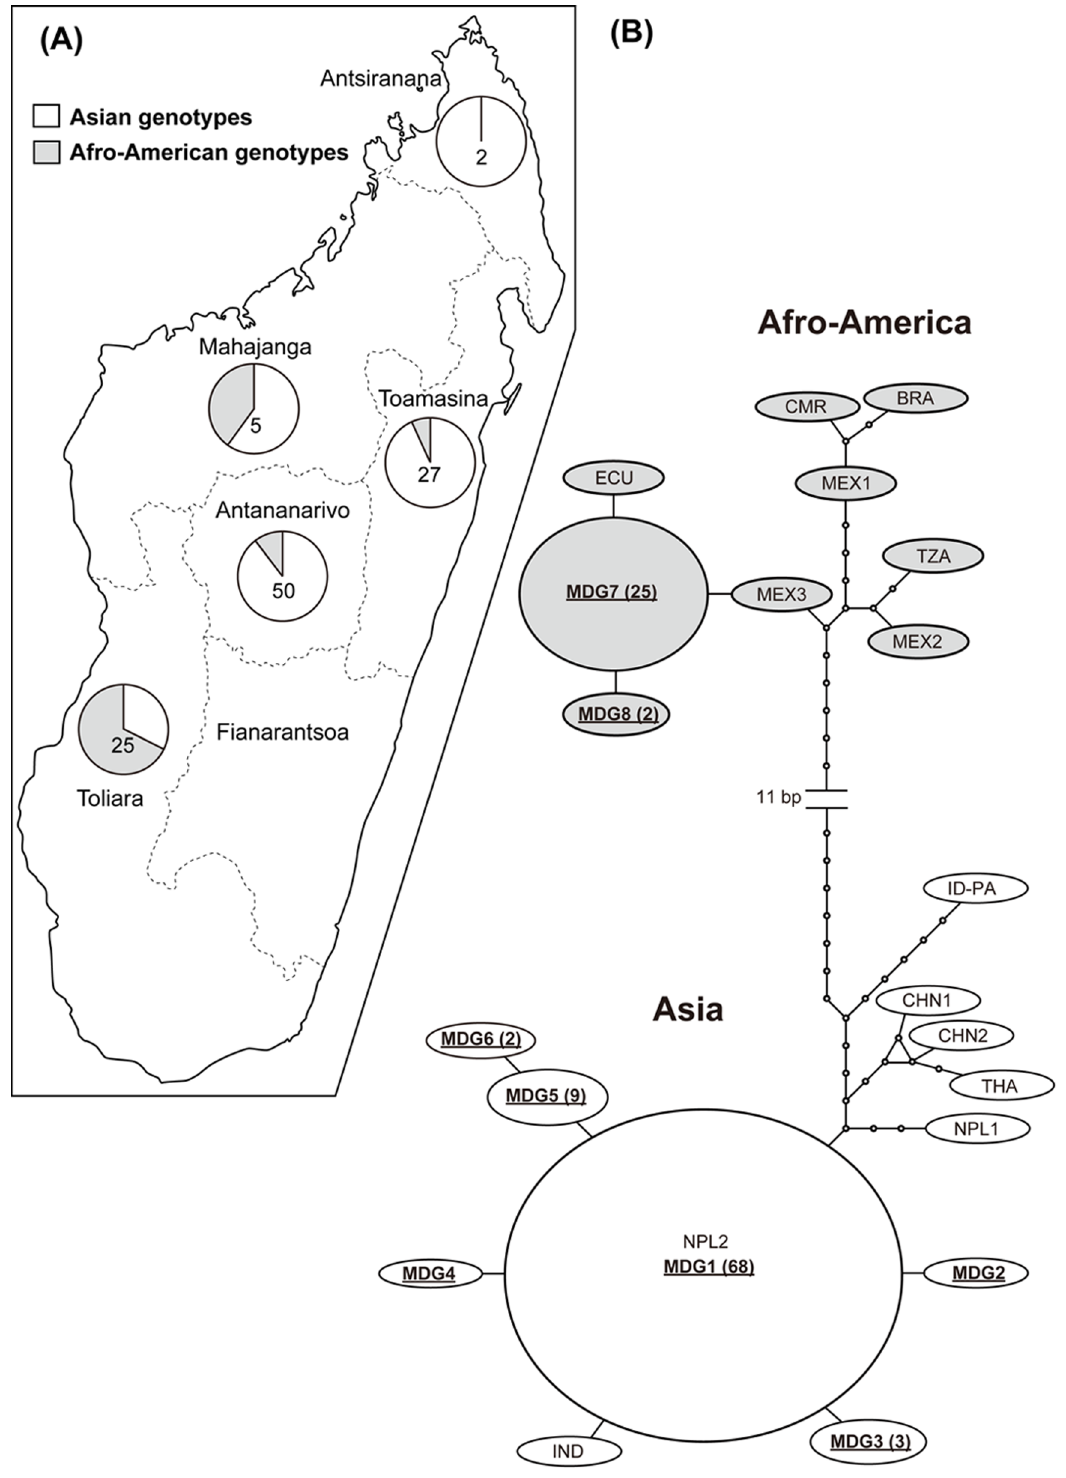
Figure 1. Mitochondrial genotypes of T.solium in Madagascar. (A) Pie charts illustrating the frequencies of the Asian and Afro-American mitochondrial genotypes of T. solium in each collection site. The numbers in the charts show the sample size for parasite isolates examined. Madagascar is divided into the 7 former provinces. (B) The haplotype network of concatenated mtDNA gene sequences. The size of the ellipses is roughly proportional to the haplotype frequency, and the actual numbers of haplotypes ( . 1) are enclosed in parentheses.